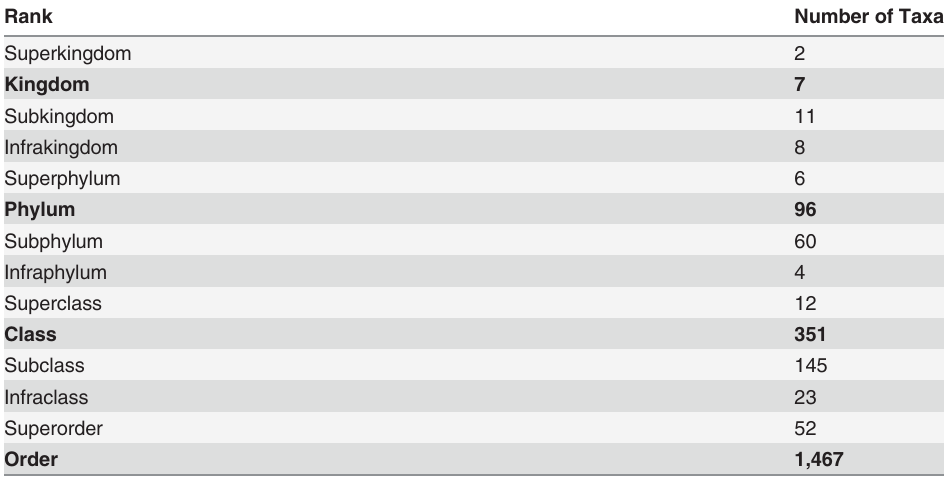
Table 1. List of ranks used in the hierarchy with the number of taxa per rank.